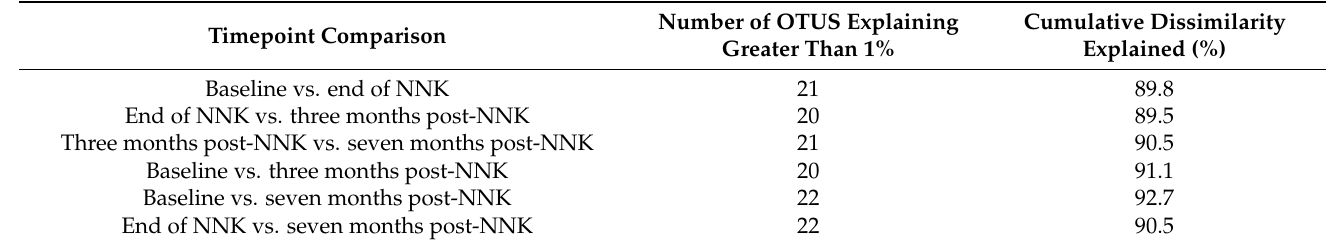
Table 1. Gprc5a − / − gut microbiome SIMPER analysis.